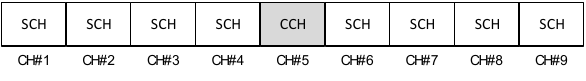
Figure 5. Example of IEEE 802.11p Channel Structure.